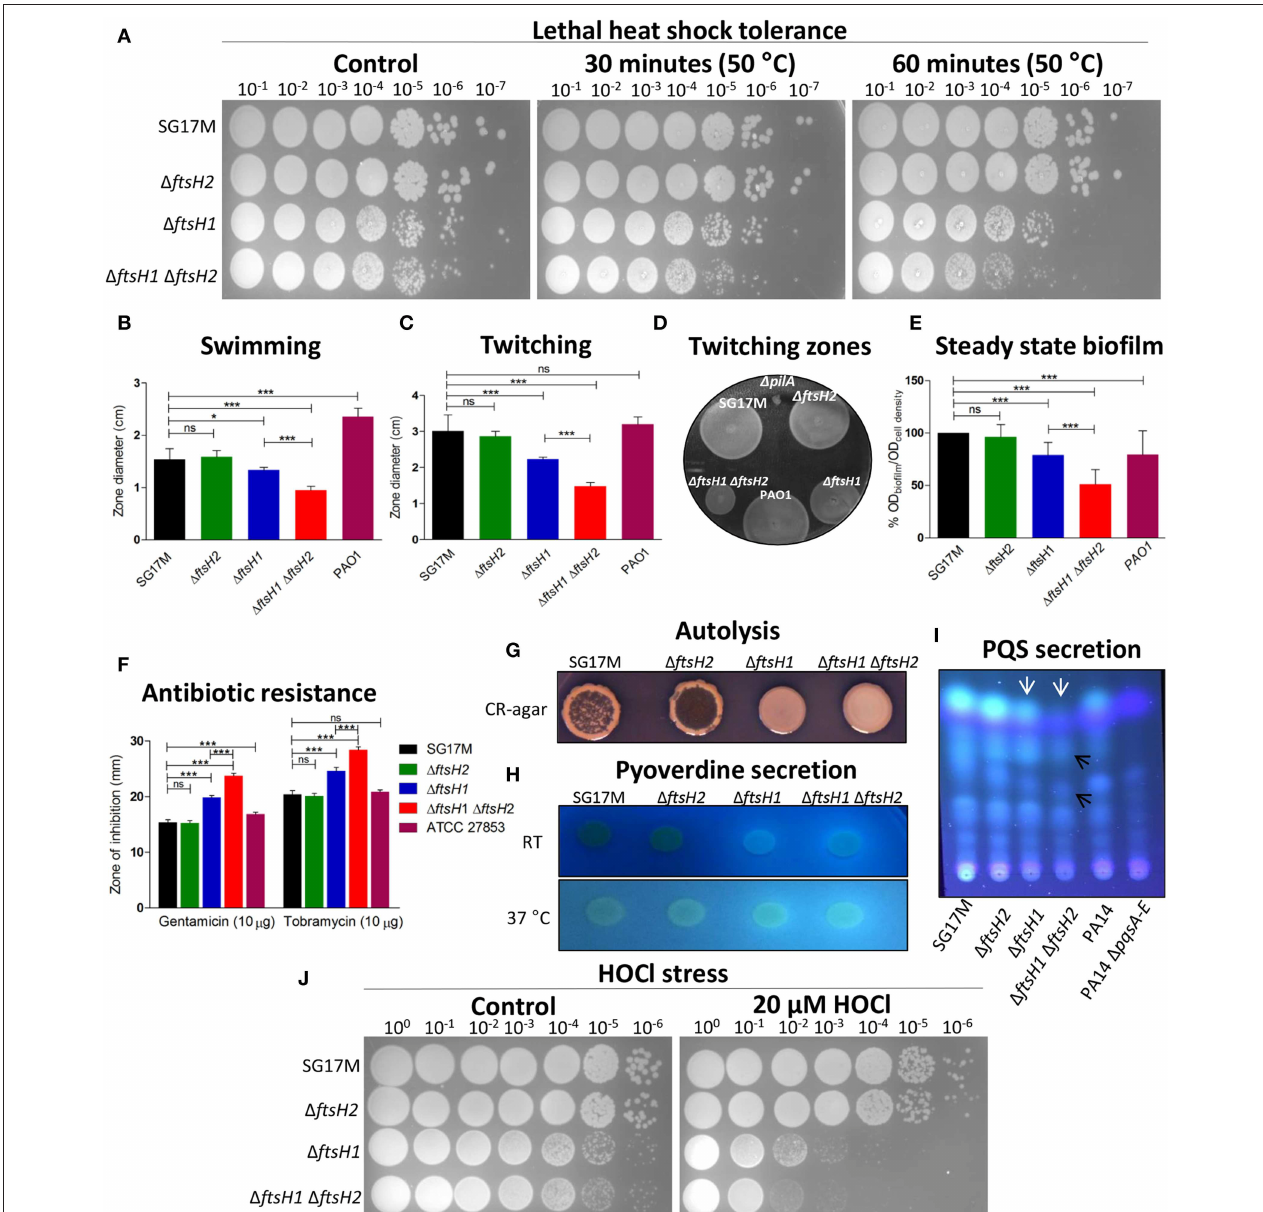
FIGURE 3 | Bacterial phenotypes affected by ftsH1 and/or ftsH2 in P. aeruginosa SG17M. The proteases contribute to tolerance toward lethal heat stress, flagella and type IV pili mediated motility, biofilm formation, antibiotic resistance, autolysis, pyoverdine secretion, PQS secretion, and resistance against hypochlorous acid (HOCl). (A) Lethal heat shock was conducted at 50 ◦ C for 30 and 60min, serial dilutions were spotted on LB agar and incubated for 24h. (B) Flagella-dependent swimming motility was tested at 37 ◦ C. The mean value was calculated from six independent experiments and error bars indicate SD (* P < 0.05 and *** P < 0.0001). (C) Pili-dependent twitching motility was tested at 37 ◦ C. The mean value was calculated from eight independent experiments and error bars indicate SD (*** P < 0.0001). (D) Zones of twitching motility on the bottom of a plastic petri plate stained with TEM developer solution (glacial acetic acid: methanol: water, 1:5:4 ratio). Pseudomonas aeruginosa PAO1 1 pilA was the negative control. (E) Relative biofilm formation in 96-well plate was assessed in LB medium at 37 ◦ C. P. aeruginosa PAO1 is a positive control. The mean value was calculated from two independent experiments in 32 technical replicates and error bars indicate SD (*** P < 0.0001). (F) Resistance against aminoglycosides (gentamicin and tobramycin) was tested using the disk diffusion test. P. aeruginosa ATCC 27853 was the reference strain. The mean value was calculated from two independent experiments with 12 technical replicates and error bars indicate SD (*** P < 0.0001)). (G) Autolysis was assessed on Congo Red (CR) medium at room temperature (21 ◦ C) after 5 days of incubation. (H) Pyoverdine production was tested on LB agar at room temperature (21 ◦ C) and 37 ◦ C. (I) PQS molecules were extracted from equal cell number at stationary phase growing at 37 ◦ C and run on thin layer chromatography (TLC) plate, PQS bands (white arrows) and affected PQS precursors (black arrows) were visualized with UV 312nm. P. aeruginosa PA14 and PA14 1 pqsA-E were used as a positive and negative control, respectively. (J) Oxidative stress by HOCl was conducted by incubating the cells with 20 µ M HOCl for 30min at 37 ◦ C. Serial dilutions were spotted on LB agar and incubated for